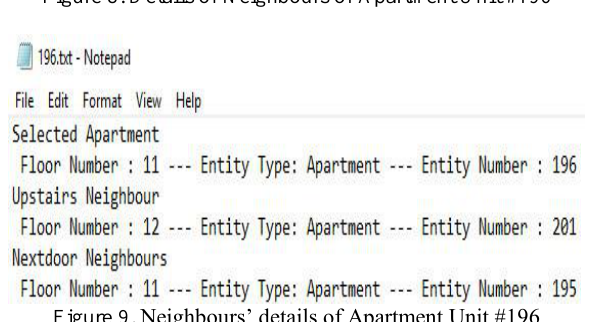
Figure 9. Neighbours’ details of Apartment Unit